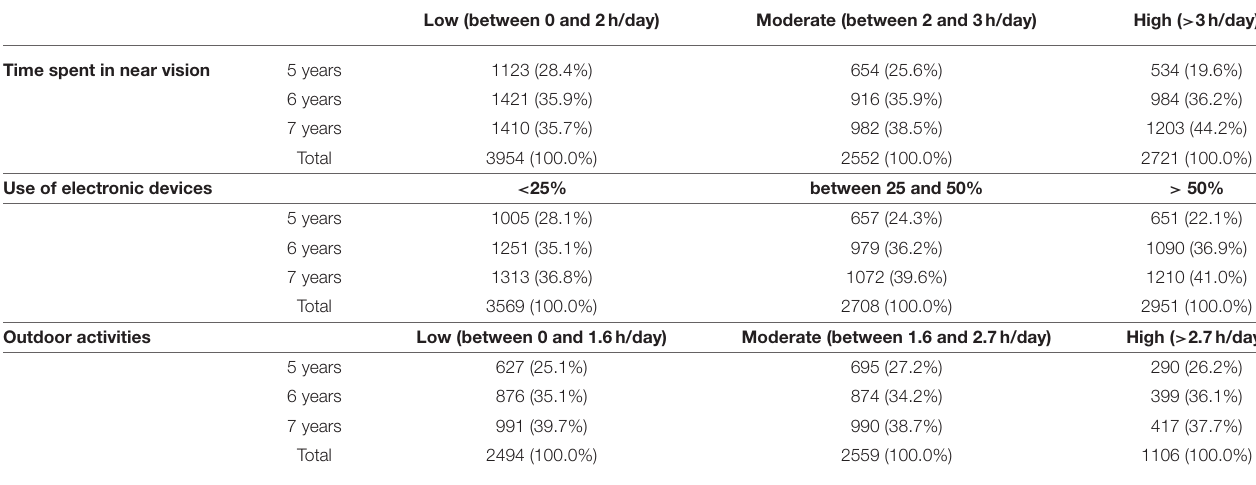
TABLE 3 | Frequency distribution of time spent in near vision, using digital devices and in outdoor activities depending on the children’s